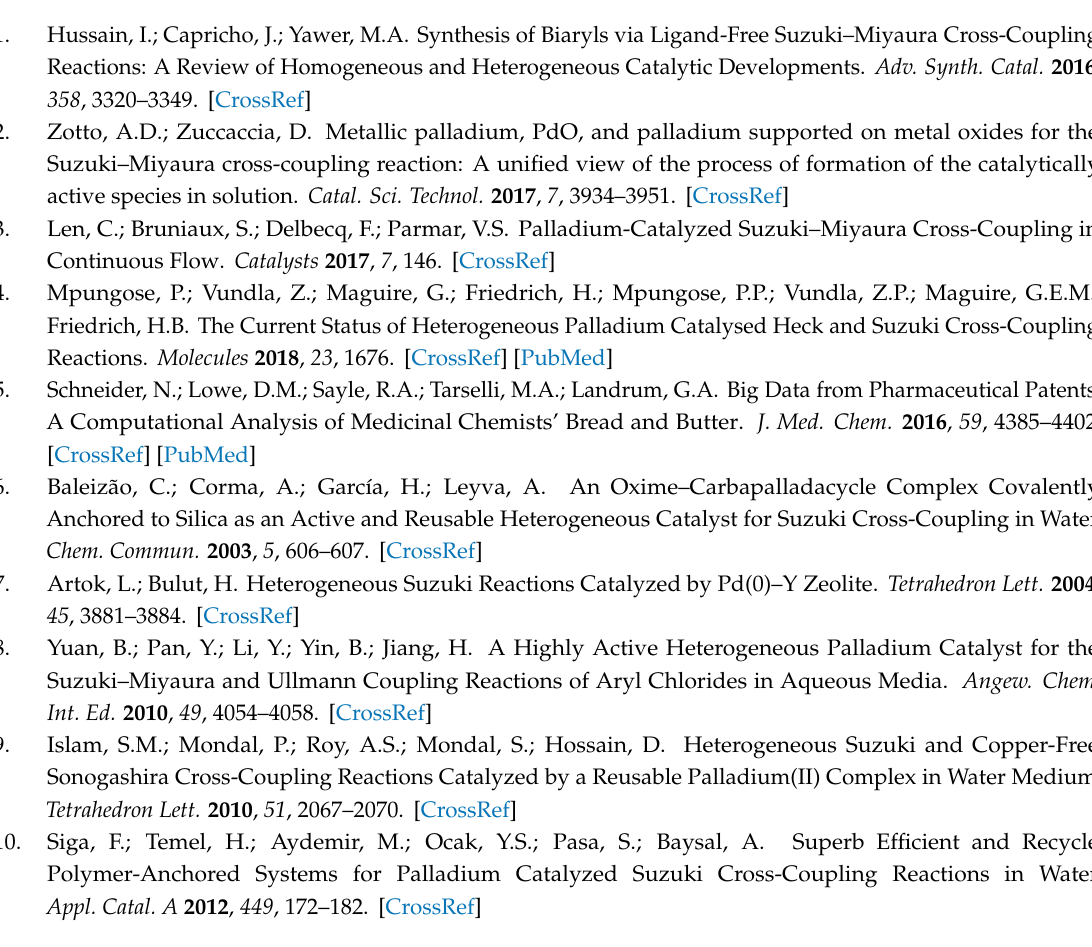
s1, Table S1: Hot filtration test (Split test), Table S2: Pd trace-analysis, Table S3: Reusability test, Table S4: Compartmented reactor with membrane, Table S5: Continuous compartmented operation (Split flow test), Table S6: 3-Phase-test, Table S7: Poisoning tests, Table S8: Microscopy